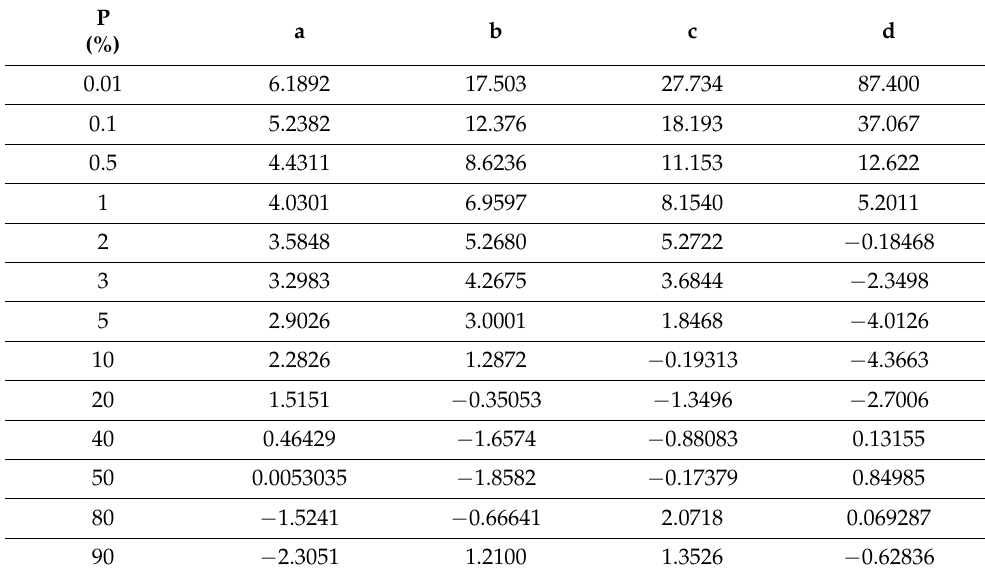
Table A5. The frequency factor for estimation with L-moments for